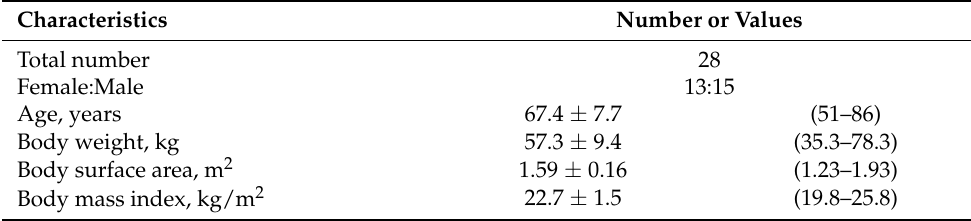
Table 1. Demographic and clinical characteristics of patients prior to afatinib therapy.